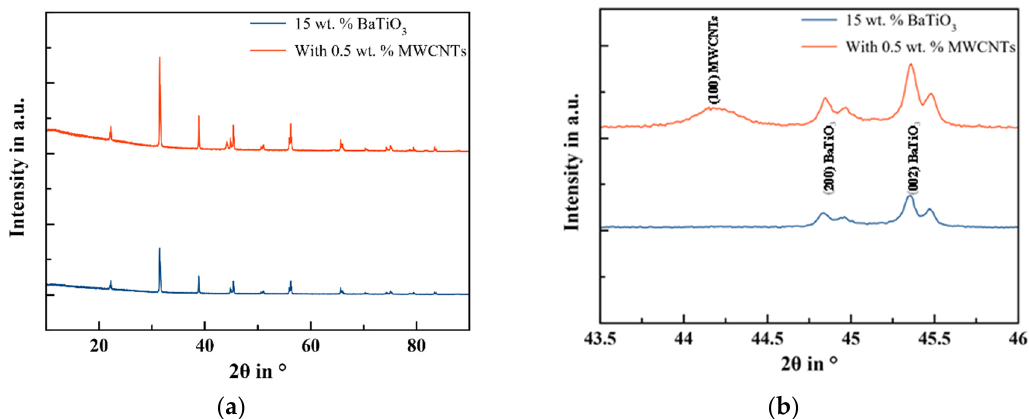
Figure 5. X-ray spectra for different composites with and without MWCNTs: ( a ) spectrum from 2 θ = 10° to 90° and ( b ) zoom view in the range of 2 θ = 43.5–46°.